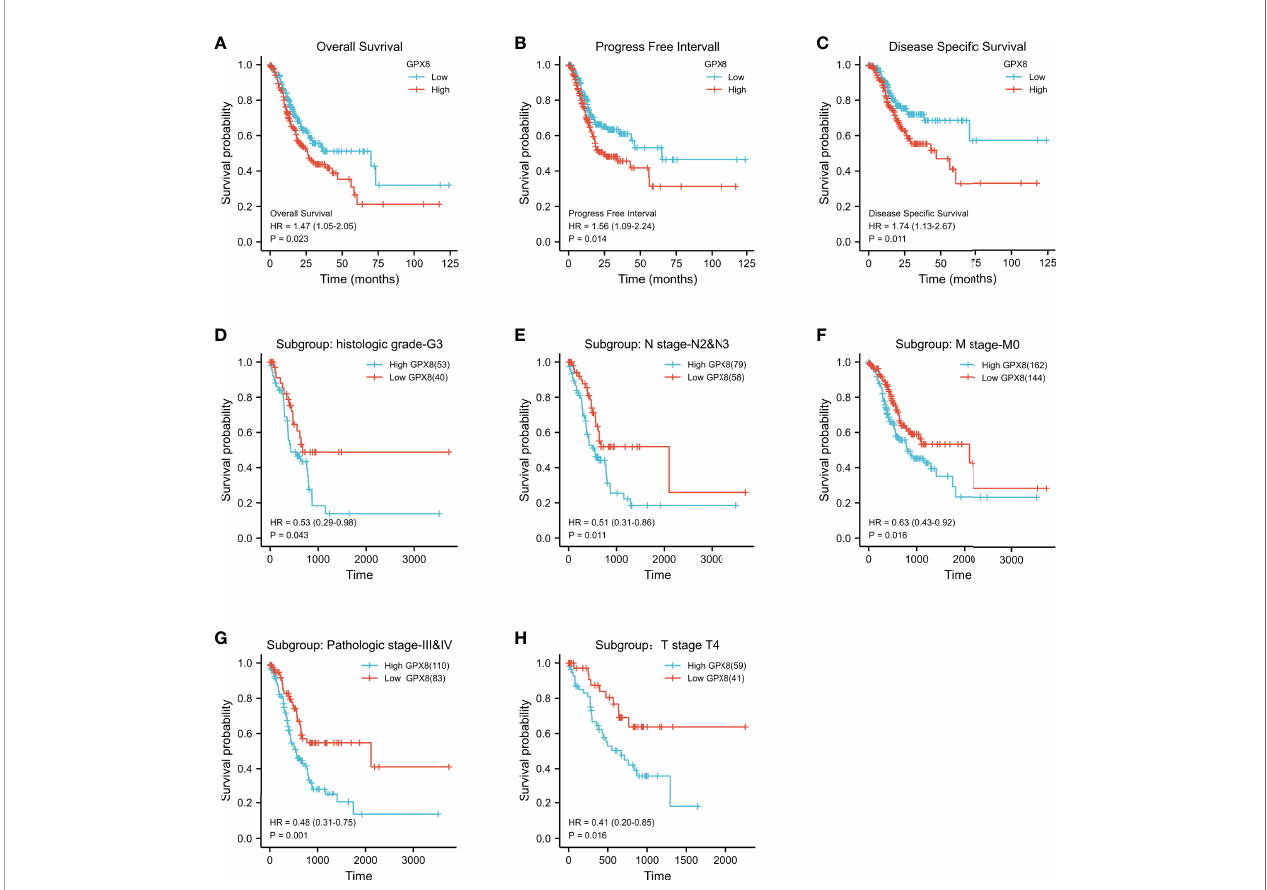
FIGURE 2 | Kaplan – Meier survival curves comparing the high and low expressions of GPX8 in STAD. (A – C) Survival curves of OS, DSS, and PFI between GPX8- high and -low patients with STAD. (D – H) OS survival curves of grade G3, N2 and N3, M0, stage III and IV, and T4 subgroups between GPX8-high and -low patients with STAD (STAD, stomach adenocarcinoma; OS, overall survival; DSS, disease-speci fi c survival; PFI, progression-free